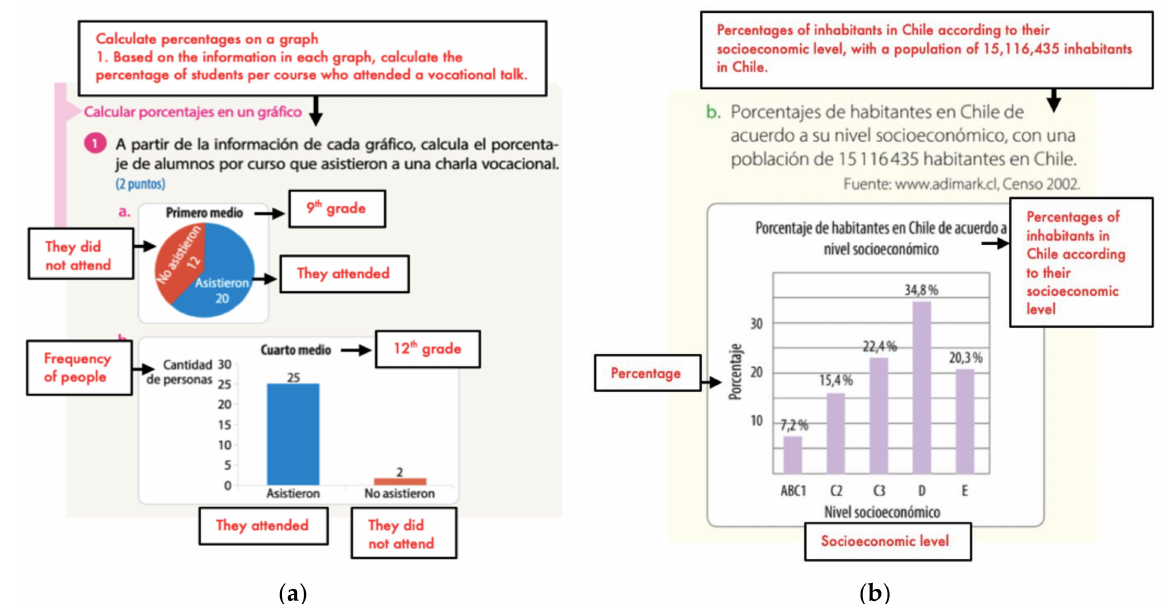
Figure 15. ( a ) Example of misuse of label, 8th Grade (Adapted from [37] (p. 290)); ( b ) Example misuse of label, 7th Grade (Adapted from [38] (p. 294)).